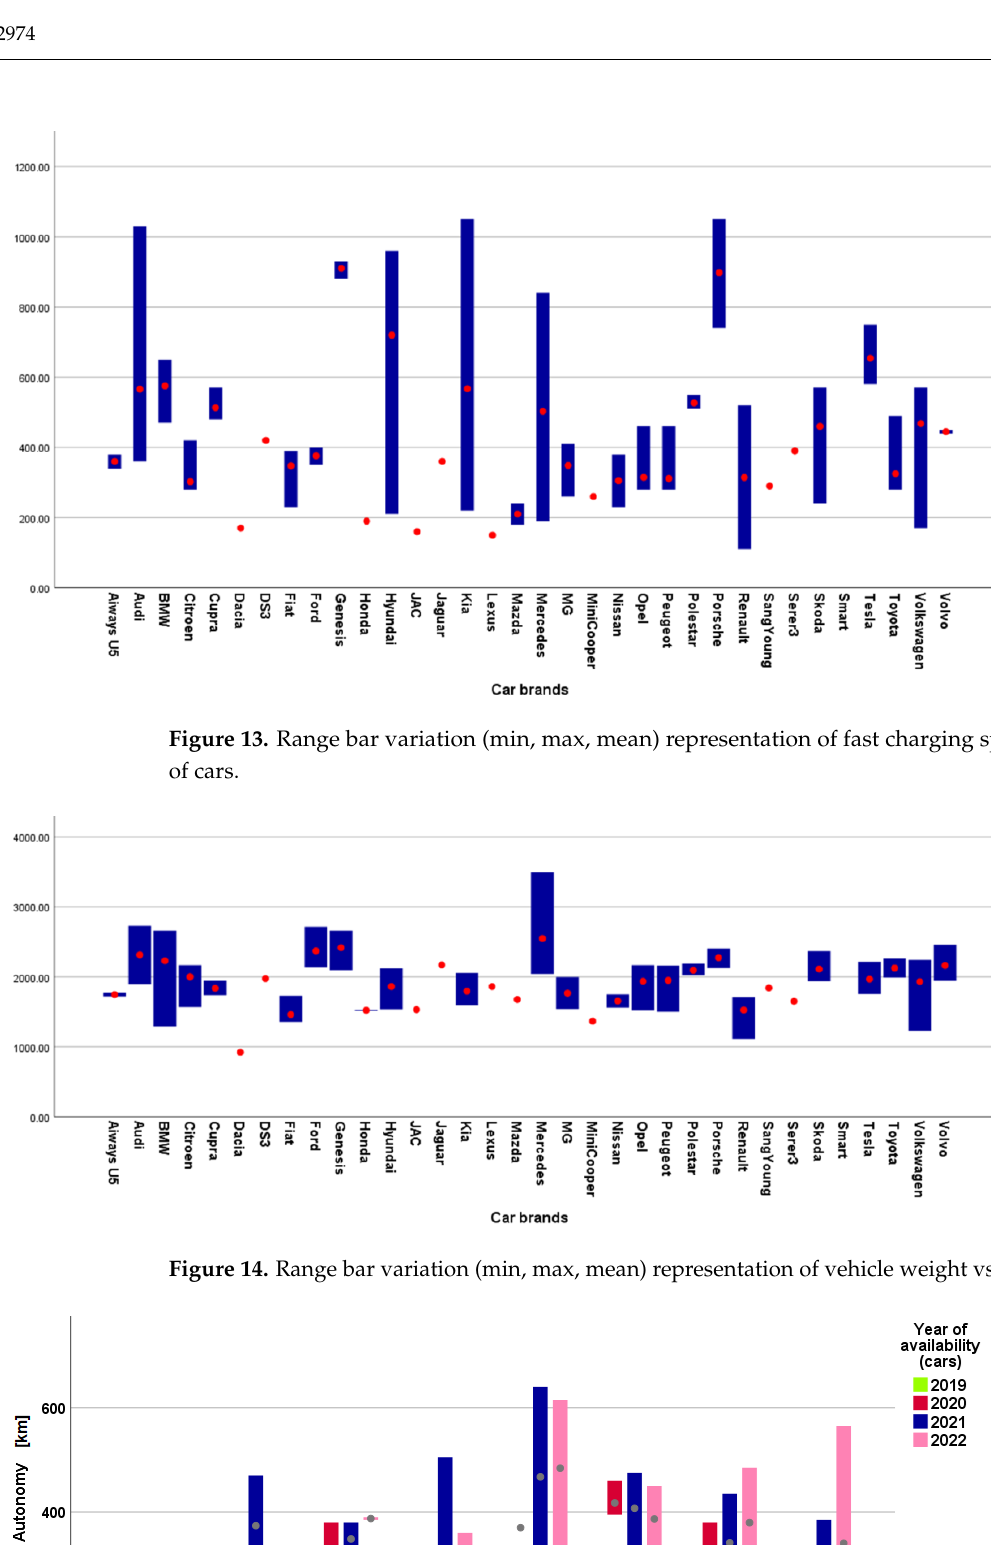
Figure 16. Range bar variation (min, max, mean) representation of battery’s energetic capacity vs. type of cars. Figure 17. Range bar variation (min, max, mean) representation of energy efficiency vs. type of cars.